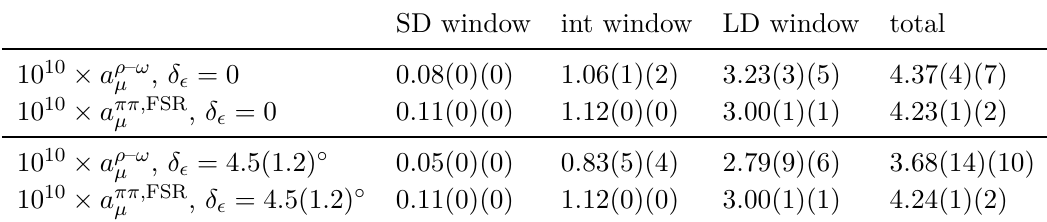
Table 4 . IB contribution to a ππ | ≤ 1 GeV due to ρ - ω mixing, compared to the effect of FSR and split µ into the different Euclidean windows from ref. [36]. We only include the linear effects, i.e., O ( (cid:15) ω ) for the ρ - ω -mixing contribution and the O ( e 2 ) effect for FSR — O ( e 2 (cid:15) ω ) effects give very small corrections. The results correspond to the combined fit to all experiments apart from SND20. The p first error is the fit uncertainty, inflated by χ 2 / dof , the second error is the combination of all systematic